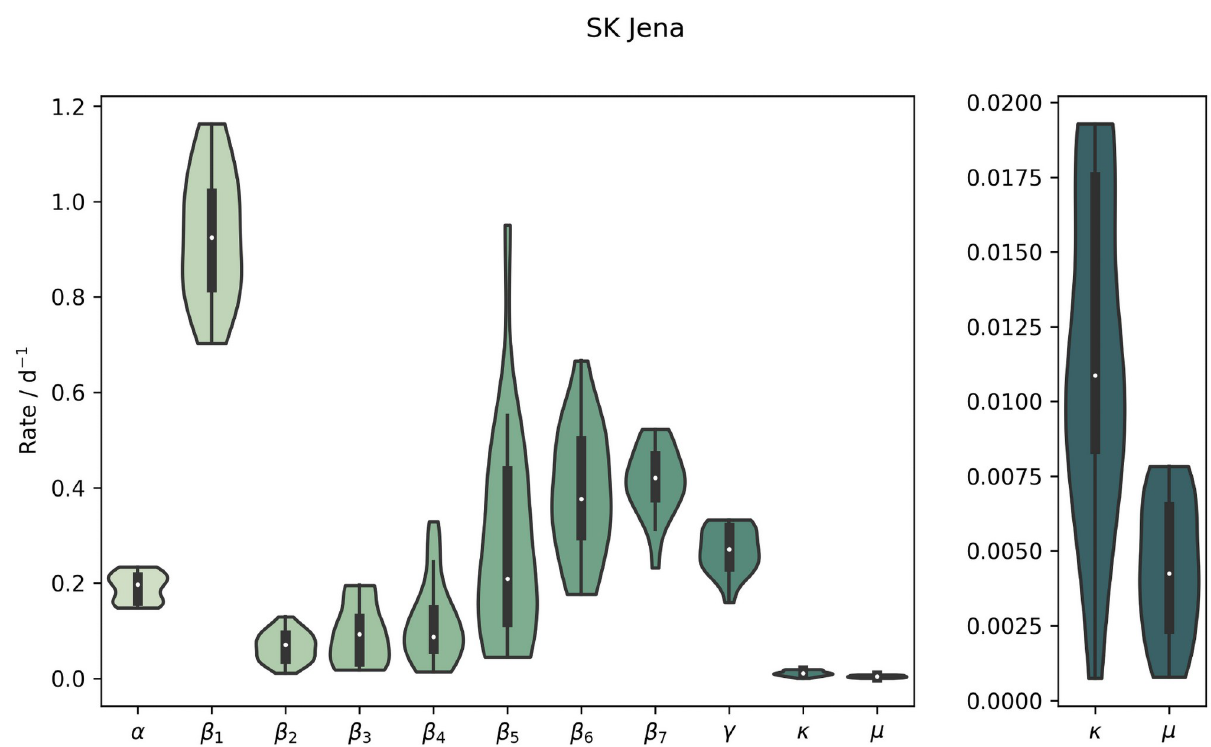
Fig 5. Posterior parameter distributions for SK Jena. The posterior distributions of the parameters for SK Jena. For better visualization, the parameters κ and μ are shown again on a separate y-scale. A classical box plot is show inside the violins, with the white dot indicating the optimal parameter.